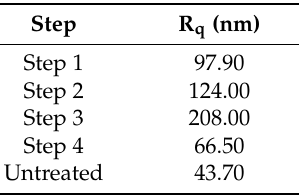
Figure 4. DI water droplet on the mixture film ( a ) untreated and ( b ) fluorinated by RIE.